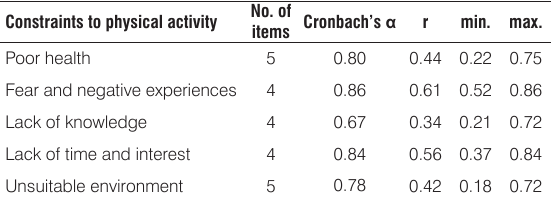
Table 3. Psychometric evaluation of the constraints on physical activity scale (160 urban Lithuanian adults aged 60-89 screened in